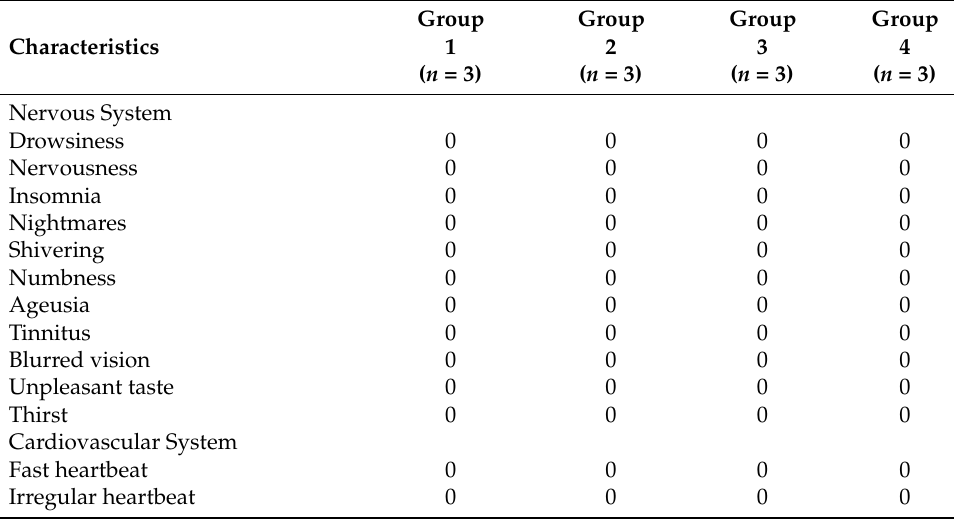
Table 3. Summary of solicited systemic advents in the first 8 days post